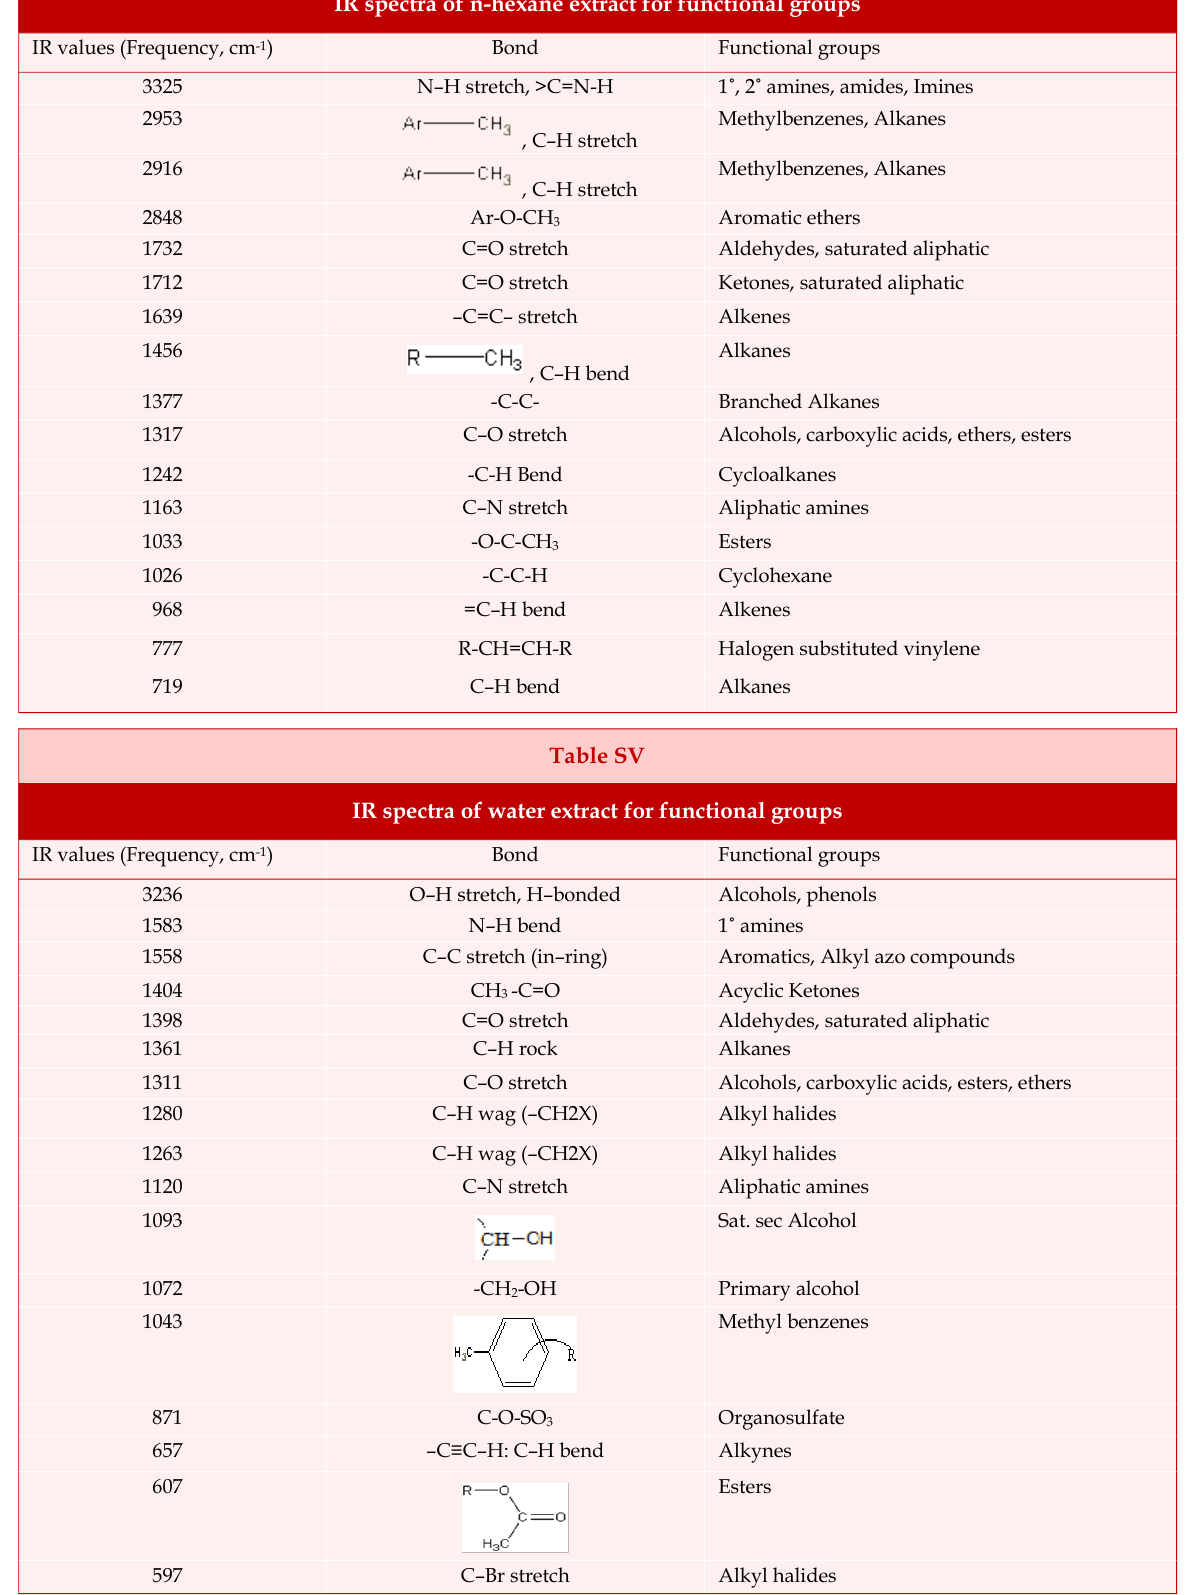
IR spectra of n-hexane extract for functional groups IR values (Frequency, cm -1 ) Bond Functional groups